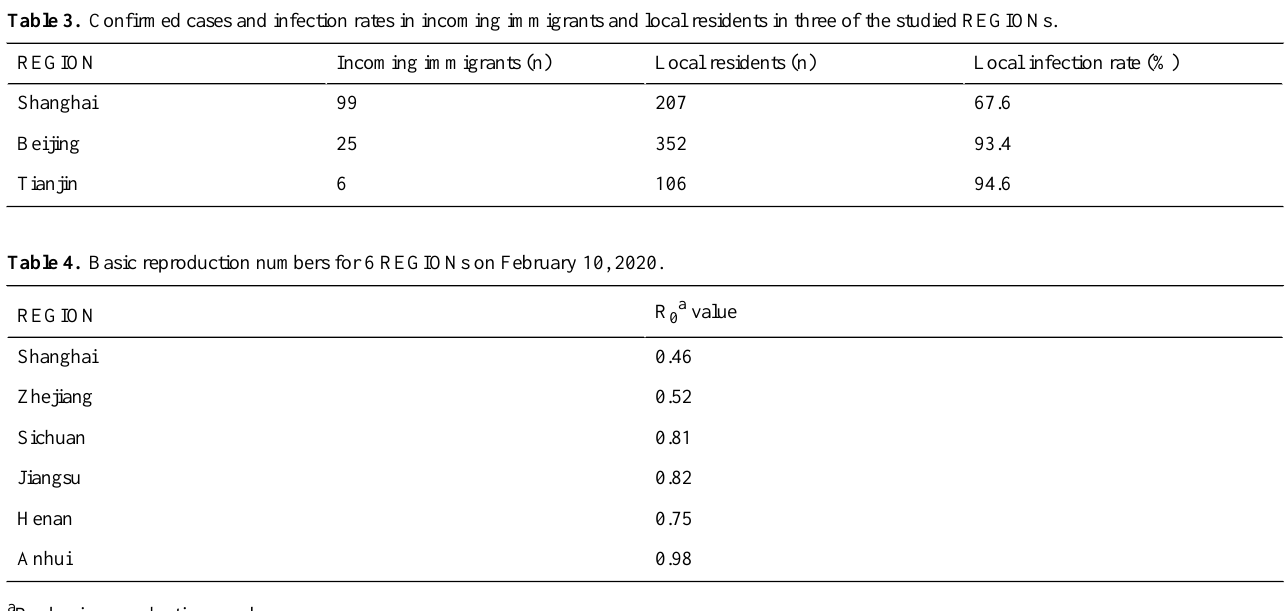
Table 3. Confirmed cases and infection rates in incoming immigrants and local residents in three of the studied REGIONs.